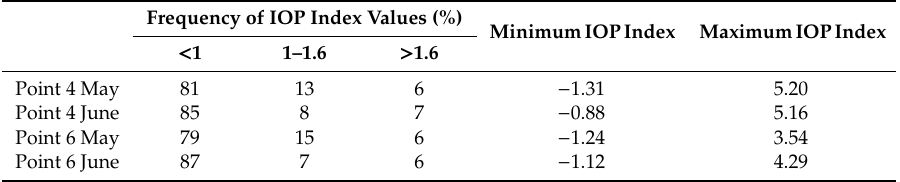
Table 2. Inherent optical properties (IOP) index statistics from 2003 to 2016. Frequency of IOP index in each interval is calculated as number of cases divided by number of total observations.